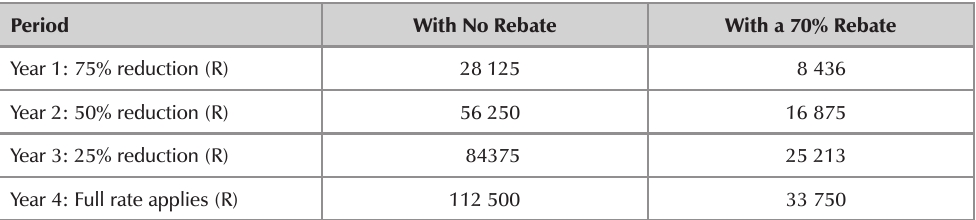
Annual land tax over the four-year phasing-in period for a 1.5 per cent tax rate: Sugarcane and timber farm, Mtonjaneni municipality, KZN (2006 =